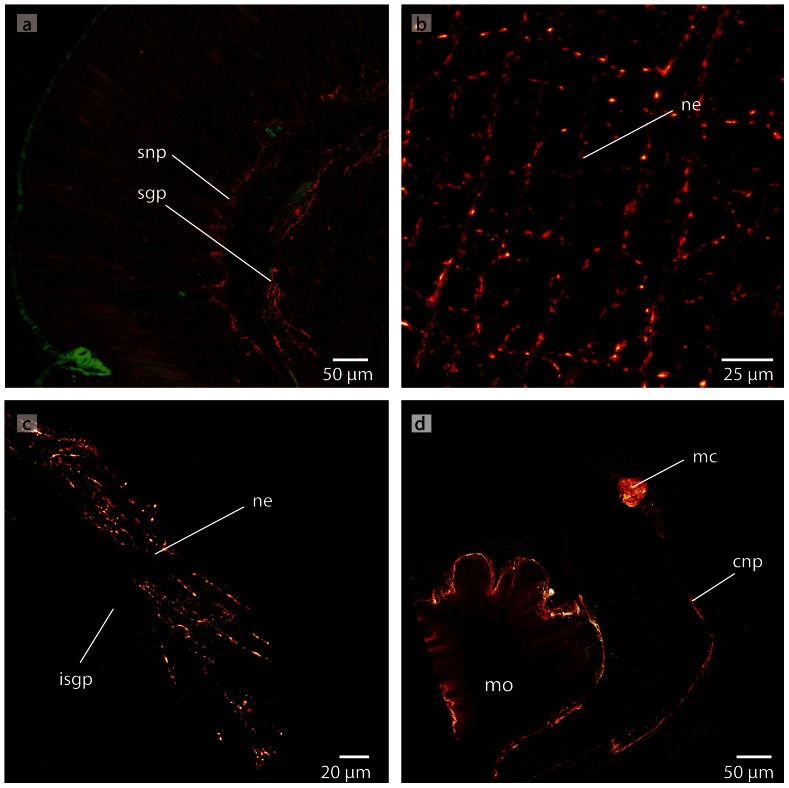

Tubulanus polymorphus, confocal laserscanning (cLSM) micrographs of differently immunostained vibratome sections.
a: Transverse section, anti-FMRF (red), anti-α-tubulin (green) showing the subepidermal (snp) and the stomatogastric (sgp) nerve plexus. b: Horizontal section, anti-FMRF showing the regular arranged neurites (ne) of the subepidermal nerve plexus. c: Horizontal section, anti-FMRF. The neurites (ne) of the intrastomatogastric nerve plexus (isgp) are arranged in a regular ladder-like fashion. d: Transverse section, anti-serotonin. The lateral medullary cords (mc) are interconnected by a commissural plexus (cnp). The commissural plexus surrounds the mouth opening (mo).